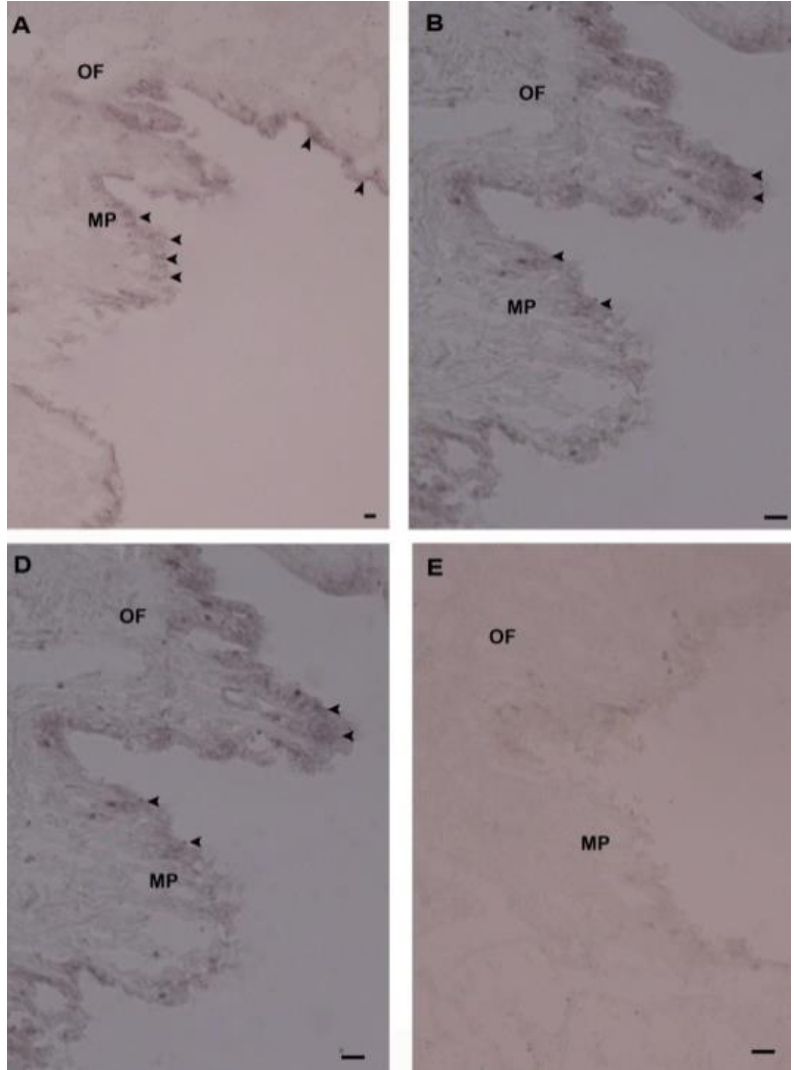
Figure 8. Detection of Hdh IGFBP7 mRNA in the mantle of H. discus hannai by in situ hybridization. ( A ) Strong hybridization signals with an antisense probe were found in the outer epithelium of mantle pallial (MP) edge, ( B ) Medium magnification of A, ( C ) High magnification showing hybridized Hdh IGFBP7 mRNA in mantle pallial (MP) edge, ( D ) No hybridization signals were observed in the control section stained with a sense probe. Strong hybridization signals are indicated with black arrowheads. Scale bar, 100 µ m. OF, outer fold; MP, mantle pallial.